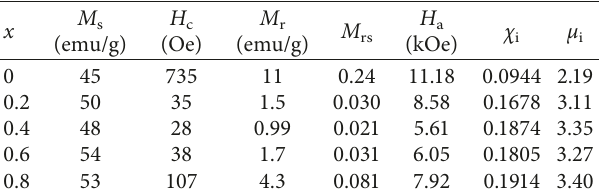
Table 3: Saturation magnetization ( M s ), remanence ( M r ), squareness ratio M rs ( � M r / M s ), coercive field ( H c ), anisotropy